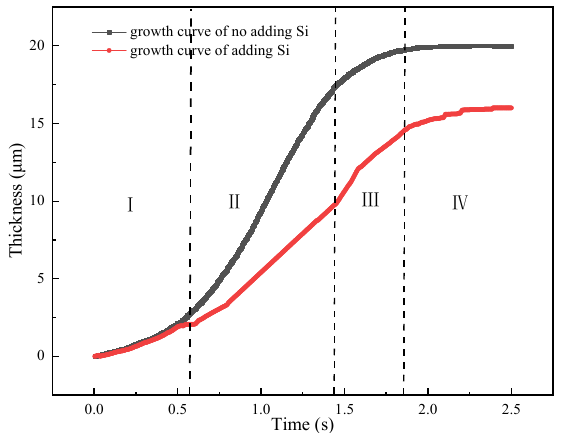
Figure 18. IMCs growth curves of adding Si element and without adding Si element and different stages of I–IV.